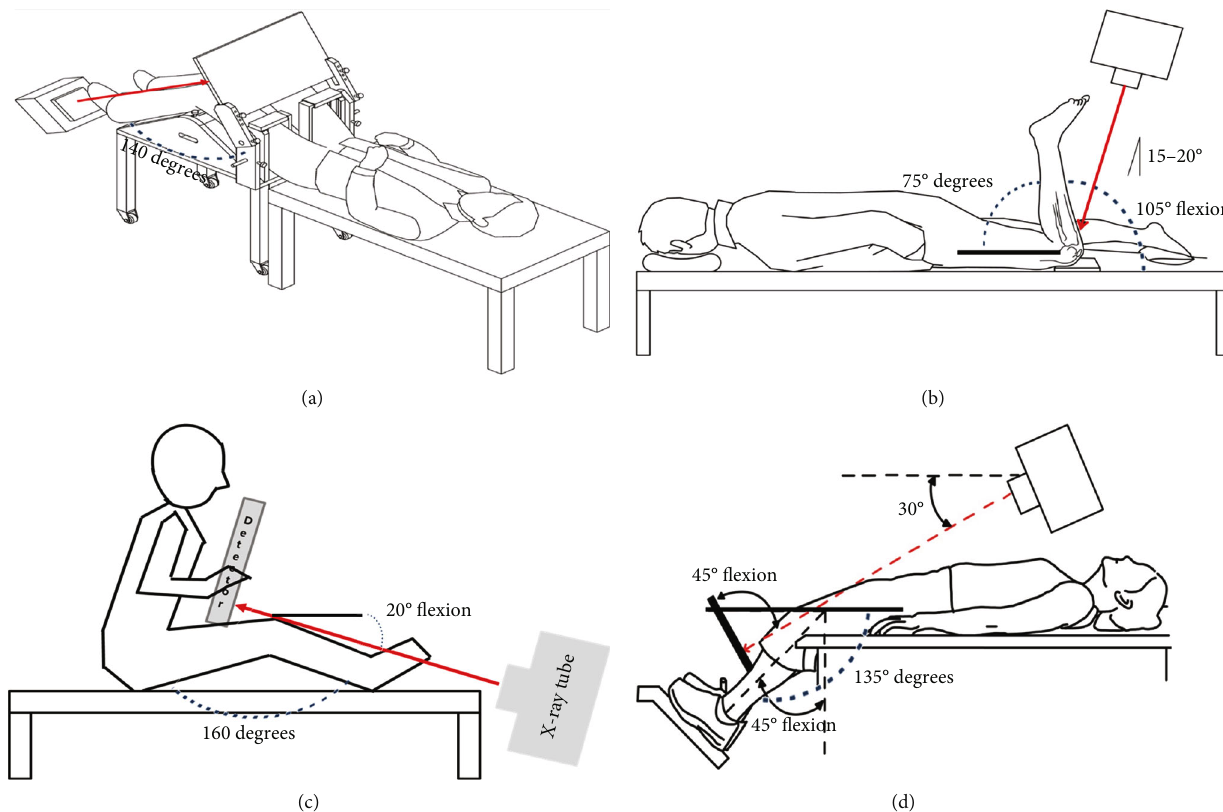
Figure 3: Patellar tangential axial radiography imaging. (a) Patellar tangential axial projection method using the PJR. (b) Settegast method. (c) Laurin method. (d) Merchant